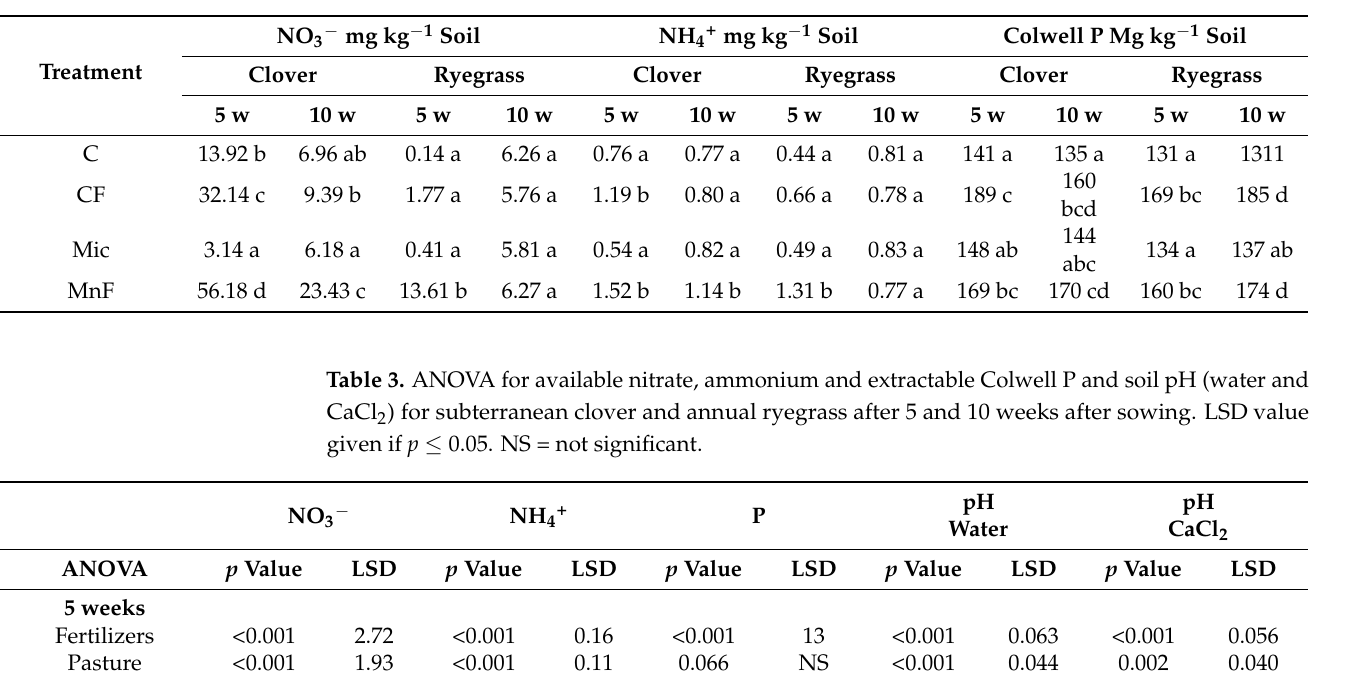
Table 2. Soil available nitrate, ammonium and extractable Colwell P for subterranean clover and annual ryegrass after 5 and 10 weeks for treatments C (control), CF (chemical fertilizer), Mic (microbial inoculant, and MnF (rock mineral fertilizer). Parameter means with the same letter are not significantly different among treatments ( p > 0.05) according to the Tukey test. Results of the two-way ANOVA are indicated for each parameter.